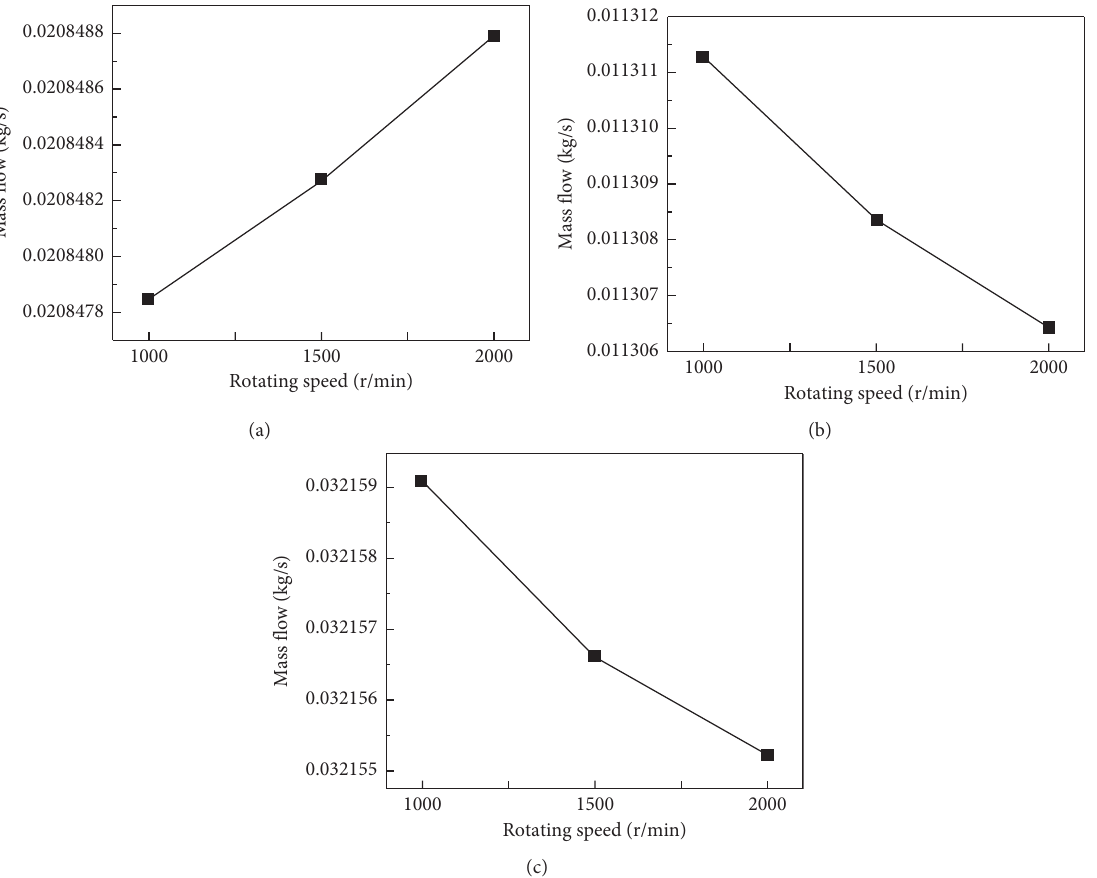
Figure 14: Leakage flow curve of end clearance at different speeds. (a) Leakage curve of internal gear area. (b) Leakage curve of external gear area. (c) Total leakage curve of end